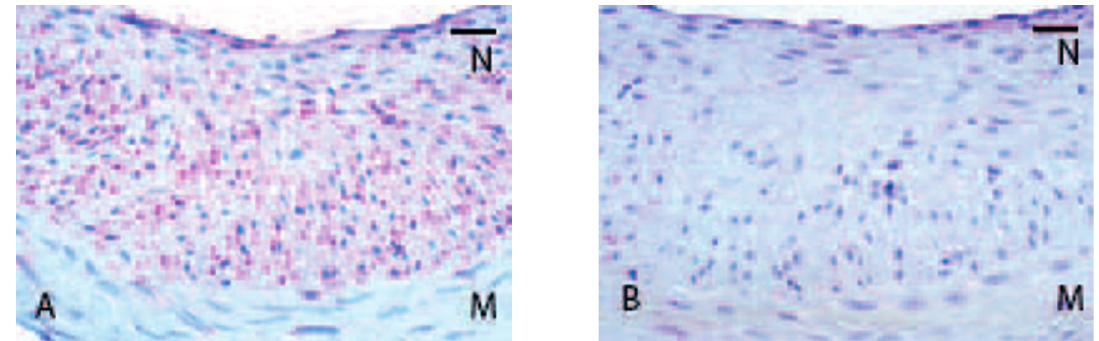
Figure 6A, B. Photomicrographs of immunostaining for HSP47+ cells in neointima at day 28 after balloon angioplasty (A, B). (A) Strong HSP47 signals in spontaneously hypertensive rats with ACE inhibitor (SHR+). (B) Sparse HSP47 signals in spontaneously hypertensive rats without ACE inhibitor (SHR-). N- neointima, M- media. For (A, B) graph bar= 20µm.